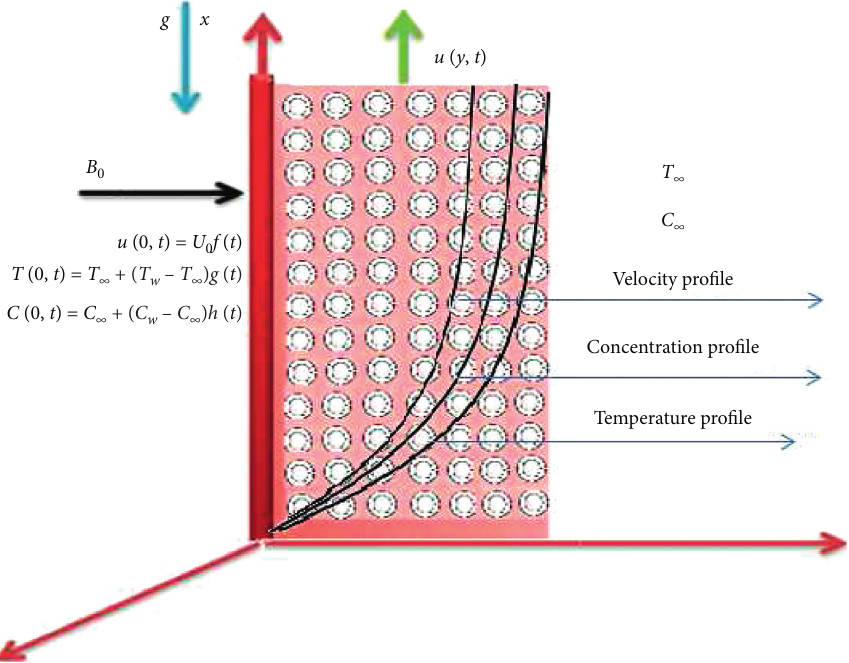
Figure 1: Flow geometry and coordinate